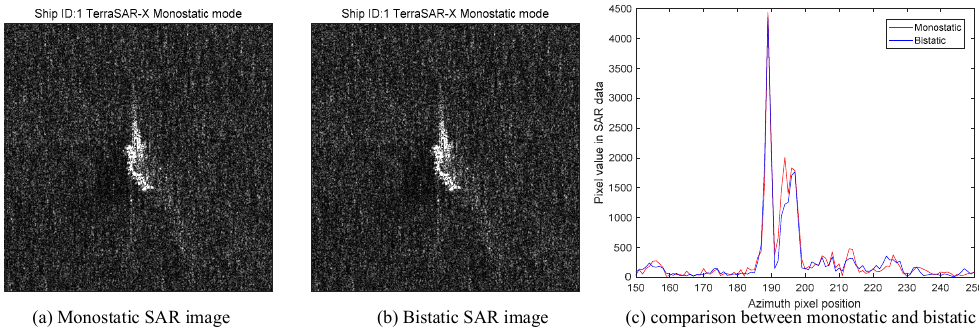
Figure 27. The five labeled ship targets in TanDEM-X image.